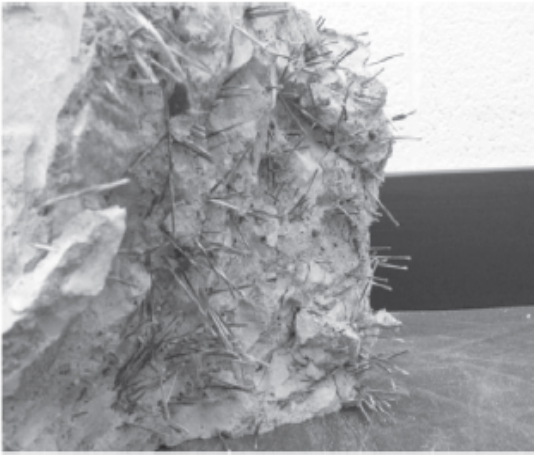
Figure 12. Fracture Surface of Concrete After Flexural Strength [38] with Elsevier permission.